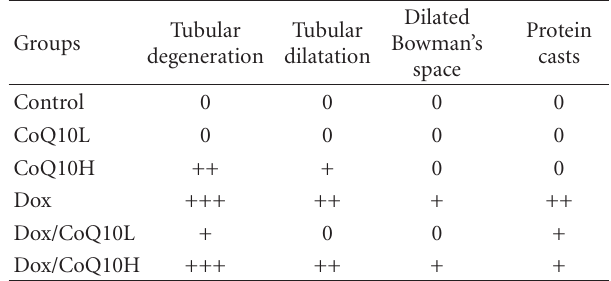
Table 2: E ff ect of coenzyme Q10 (CoQ10) on severity of